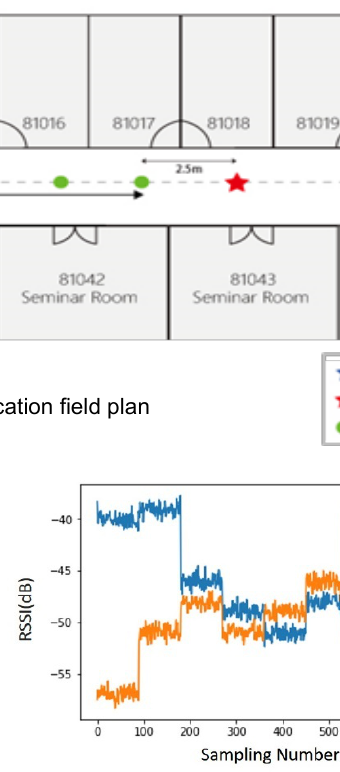
Figure 12. RSSI fluctuations at each observation point in Figure 10